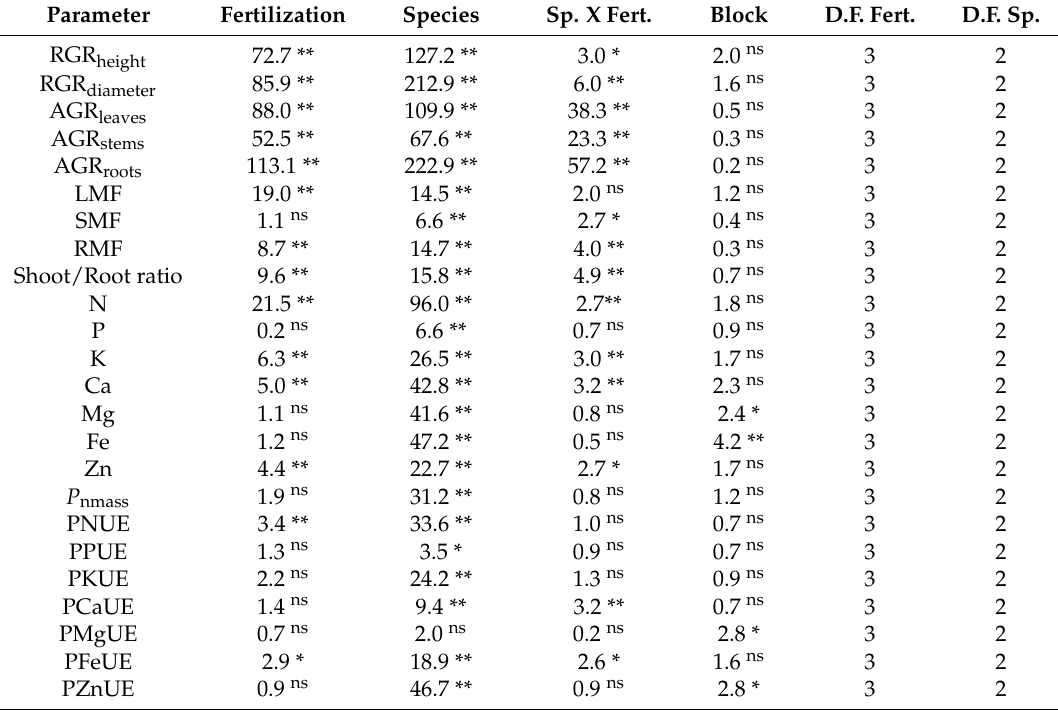
Table 3. ANOVA results (F values) ( n = 6) for the species and fertilization treatment factors and the interactions between the factors (Sp. X Fert.). Parameters: relative growth rates of height (RGR h ) and diameter (RGR d ); absolute growth rates of leaf biomass (AGR leaves ), stem biomass (AGR stems ), and root biomass (AGR roots ); leaf mass fraction (LMF); stem mass fraction (SMF); root mass fraction (RMF); shoot/root ratio (S/R ratio); foliar nutrient contents of nitrogen (N), phosphorus (P), potassium (K), calcium (Ca), magnesium (Mg), iron (Fe) and zinc (Zn); net photosynthetic rate ( P nmass ); and the photosynthetic nutrient use efficiencies of N (PNUE), P (PPUE), K (PKUE), Ca (PCaUE), Mg (PMgUE), Fe (PFeUE) and Zn